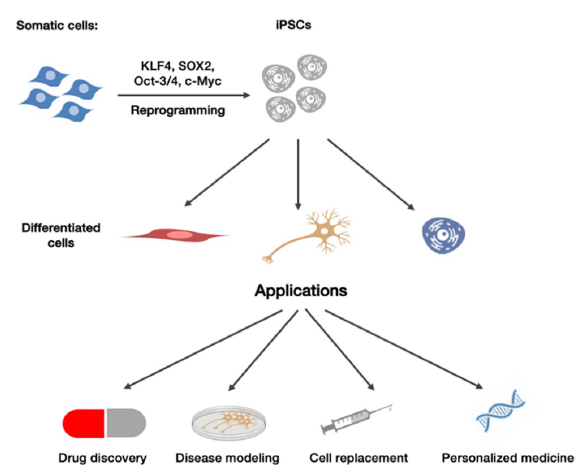
Figure 1. iPSCs obtainment and potential applications. Somatic cells can be taken from several sources and reprogrammed to iPSCs, which can be differentiated into diverse cell lines that can be used for disease modelling, drug discovery, and for cell replacement